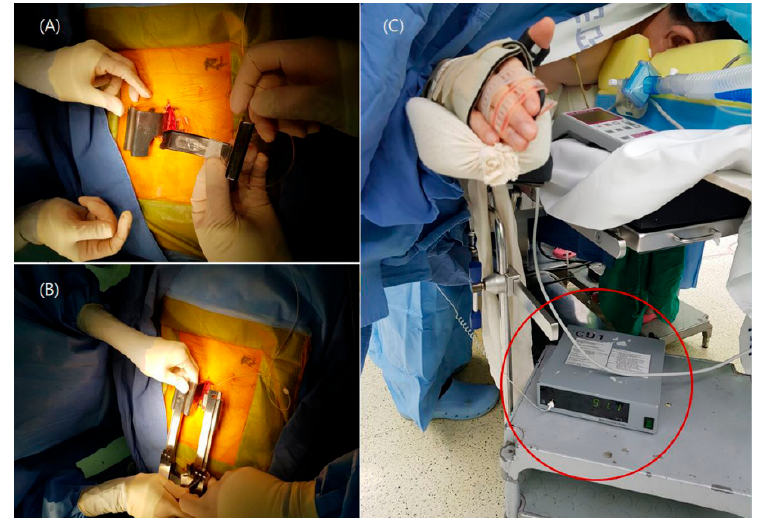
Figure A3. The retractor pressure transducer setting. ( A ) A flat planar pneumatic pressure transducer was placed beneath the lumbar retractor blade ( B ) then the lumbar retractor blades were retracted until they reached the lateral margin of the bilateral facet joints, and ( C ) the value of the back muscle retractor pressure (mmHg) was shown via a pressure monitor (red circle).